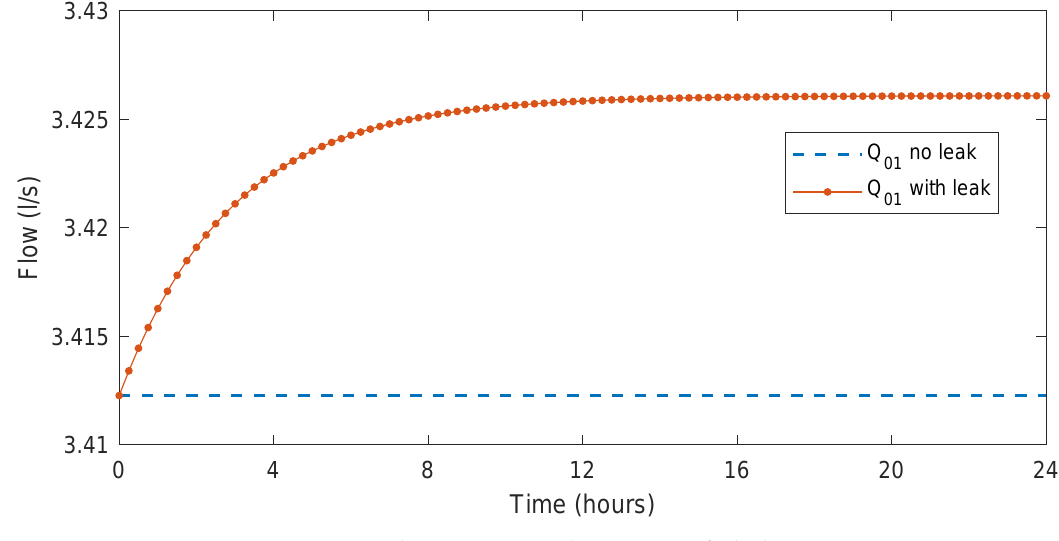
Figure 8. Flow variation in the presence of a